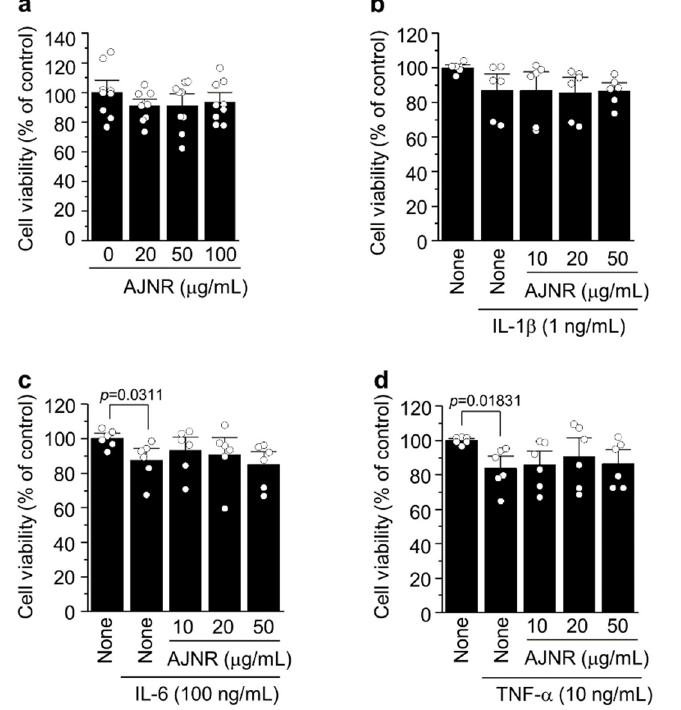
Figure 2. Effects of AJNR on the viability of primary cultured articular chondrocytes. ( a ) Primary cultured mouse articular chondrocytes were exposed to increasing concentration (0–100 µg/mL) of AJNR for 24 h and then subjected to MTT assay. The other groups were treated with AJNR (10, 20, 50 µg/mL) in the absence or presence of IL-1β (1 ng/mL) ( b ), IL-6 (100 ng/mL) ( c ), or TNF-α (10 ng/mL) ( d ), and then the cell viability of primary chondrocytes was evaluated by MTT assay. The results are representative of three independent experiments. Values are presented as the mean ± SEM and were evaluated using the two-tailed t -test.